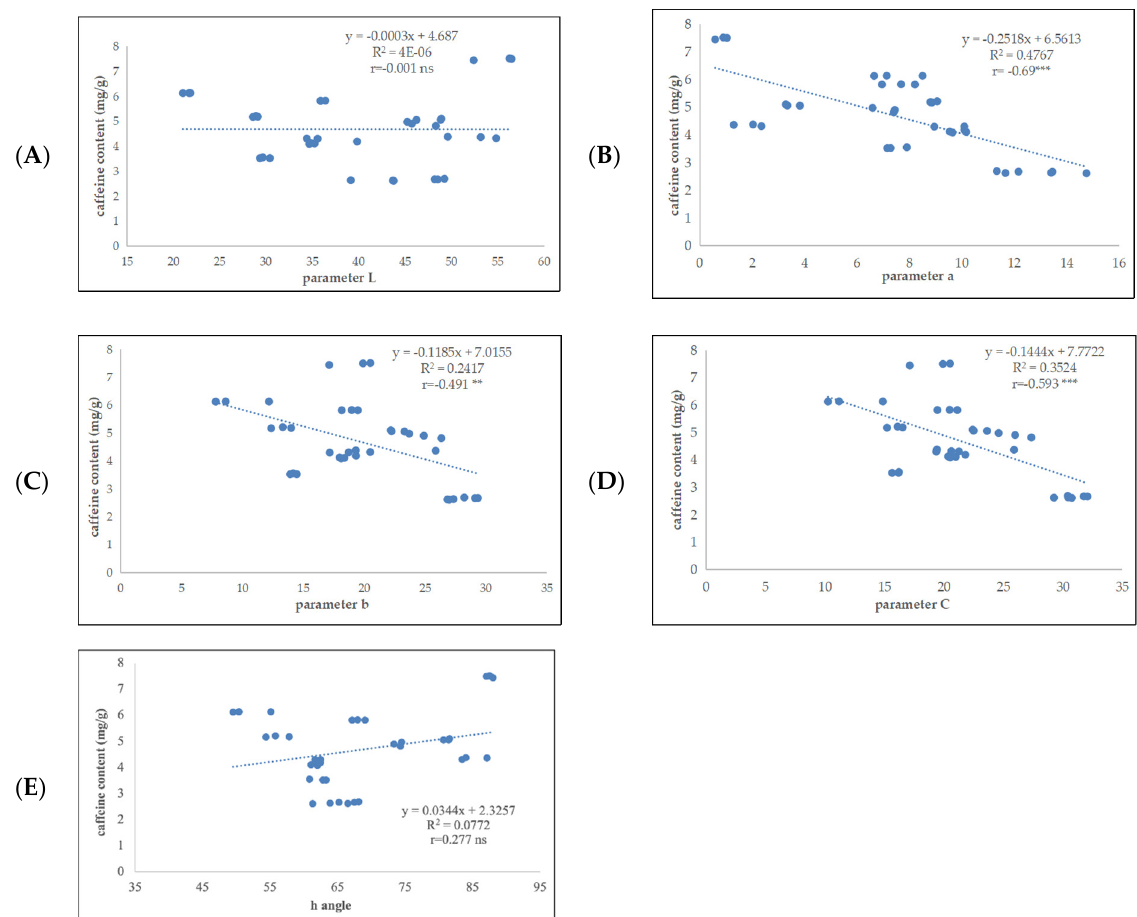
Figure 5. The correlation between roast coffee seed color ( A ) L*, ( B ) a*, ( C ) b*, and ( D ) C*, and ( E ) hue angle with caffeine content. (*: p < 0.05, **: p < 0.01, ***: p < 0.001, ns: no significant).